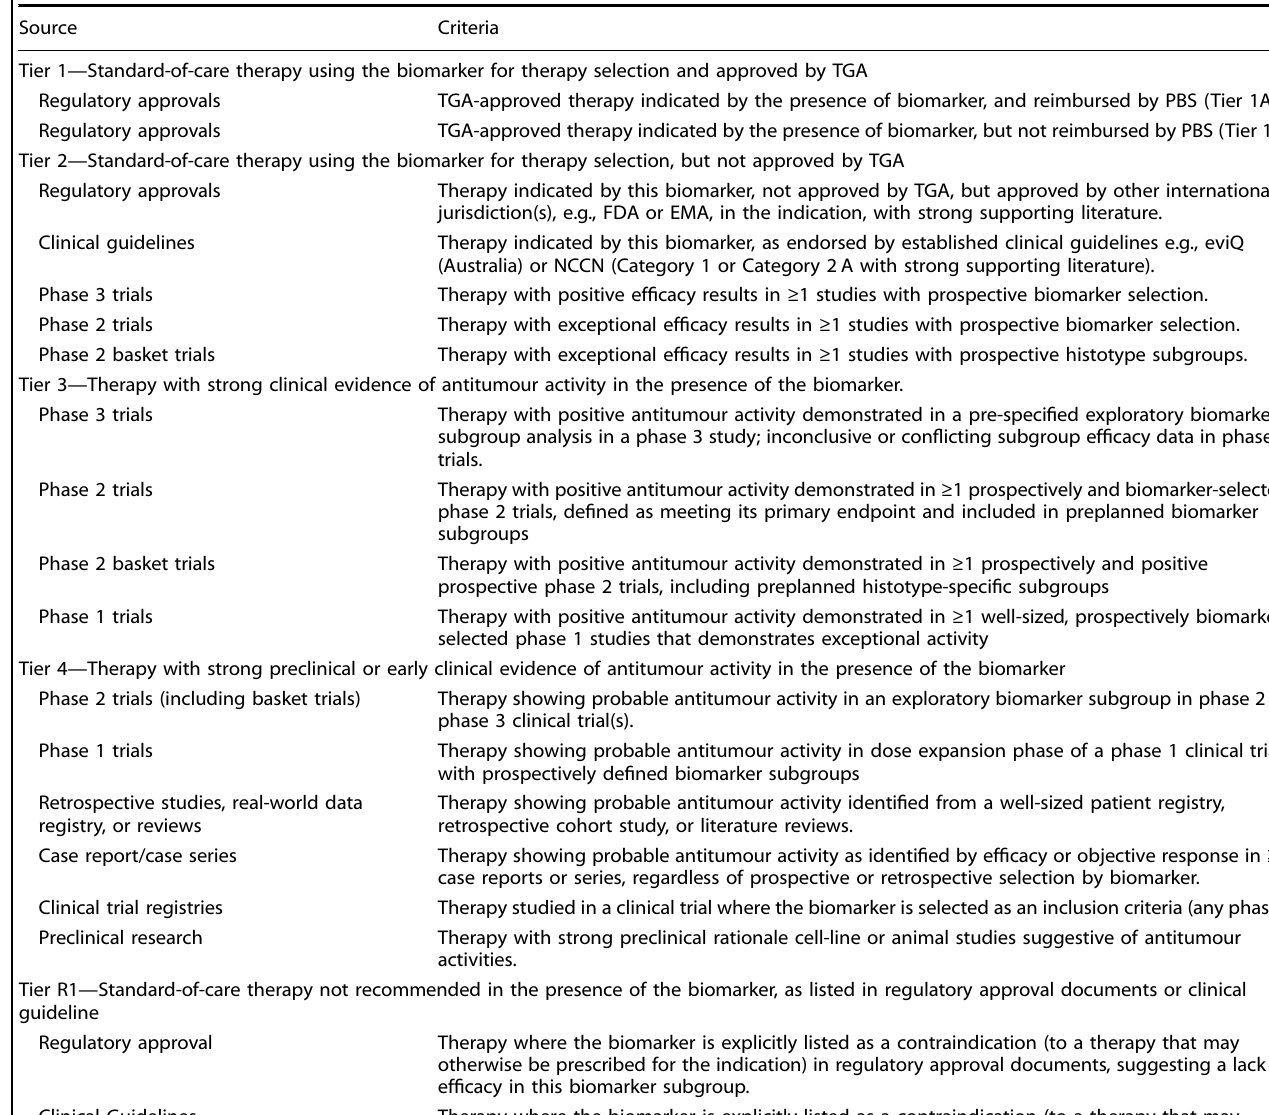
Table 2. De fi nition of therapy recommendation tiers with literature assessment criteria used for curating TOPOGRAPH with therapies listed in